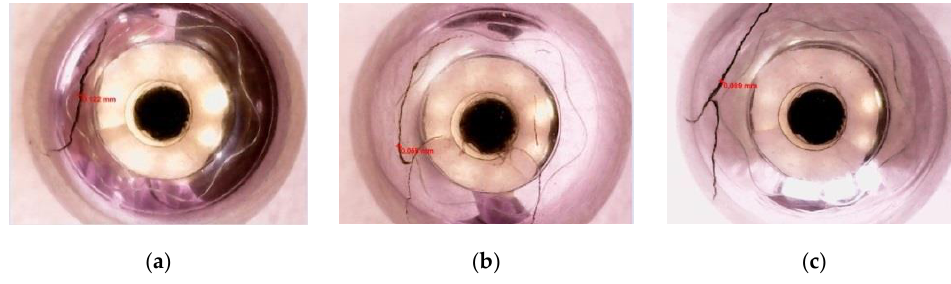
Figure 10. Samples of steel ball defects. ( a ) Linear cracks; ( b ) Arc cracks; ( c ) Cross cracks.